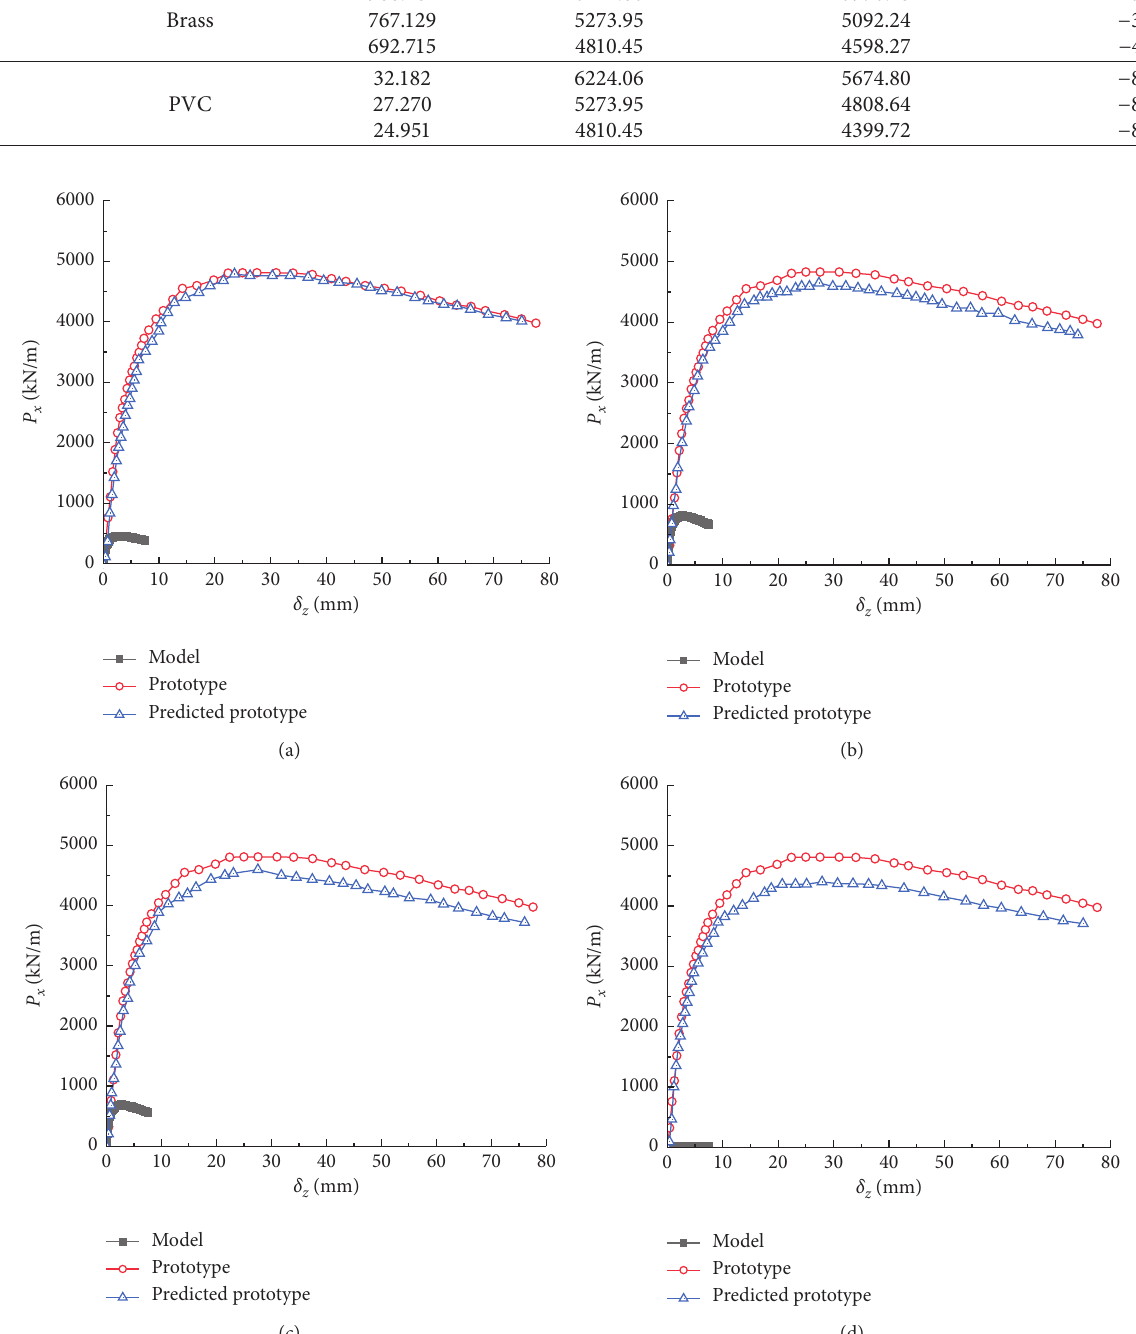
Figure 6: Comparison of partial similitude load-displacement curves for axial compression nonlinear buckling of the stiffened cylindrical shell when δ 0 � 0.5 t . (a) The model material is aluminum. (b) The model material is copper. (c) The model material is brass. (d) The model material is